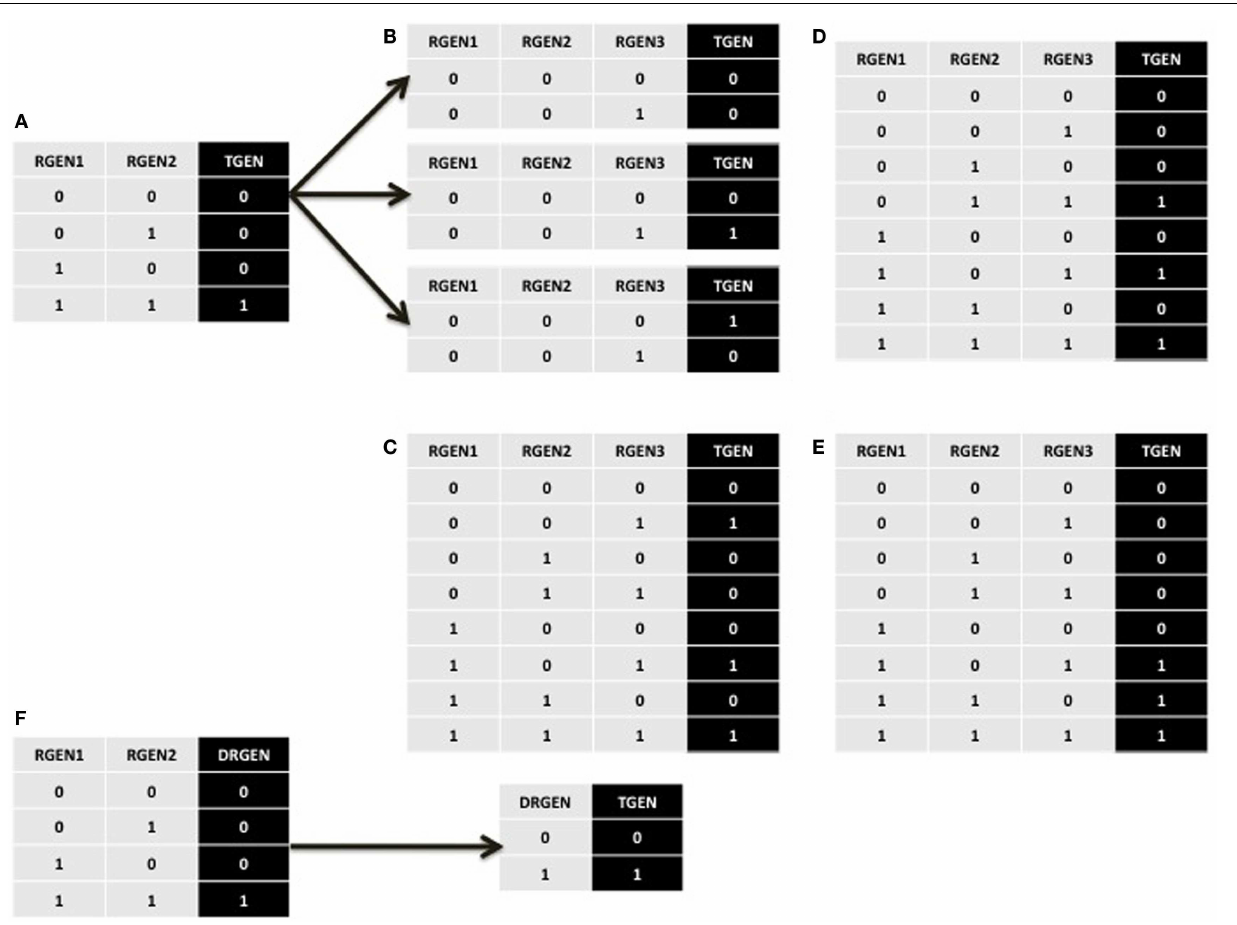
and RGEN2 observed in (A) changes to an OR operator indicating that they do not need to form a dimmer. (E) A truth table where RGEN2 can be substituted by RGEN3 from the RGEN1-RGEN2 dimer. (F) When two RGENs can only act as a dimer, and none of them can be substituted in the dimer, we can create a node that represents the dimer.The truth table observed in (A) where RGEN1 and RGEN2 regulateTGEN activity is substituted by a new truth table where the activity of the RGEN1-RGEN2 dimer is incorporated into a single